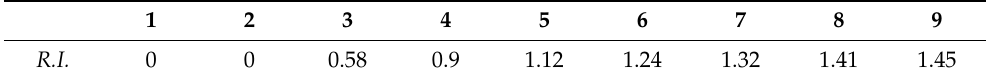
Table 3. The value of